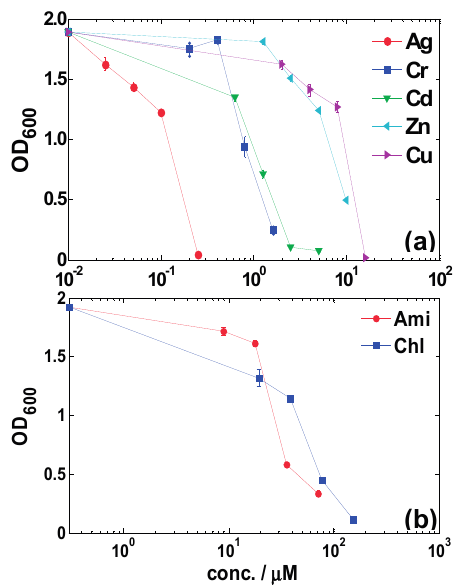
Figure 2. ( a ) Dose–response inhibitions of heavy metals on the growth of LSJC7; ( b ) Dose–response inhibitions of antibiotics on the growth of LSJC7. Ampicillin (Amp), chloramphenicol